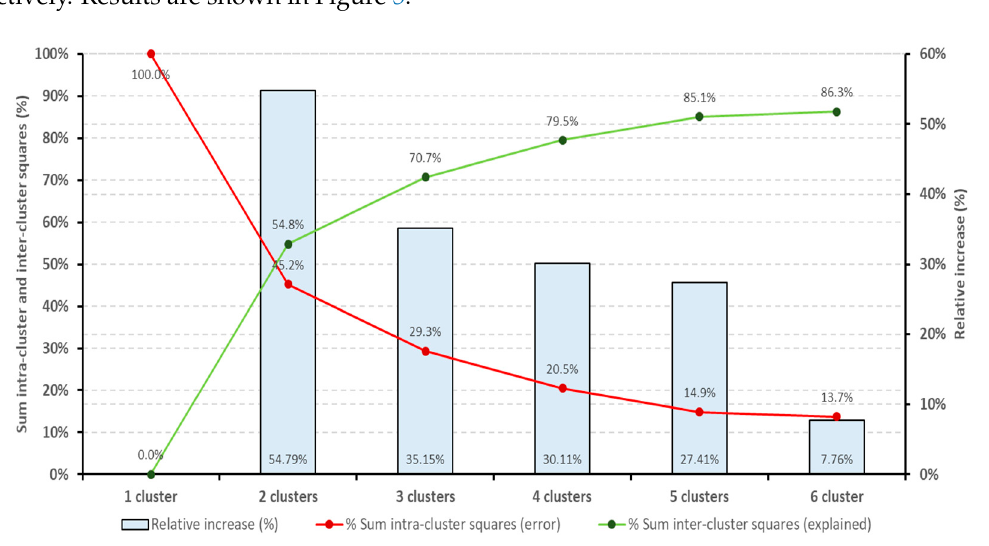
Figure 5. Results for the k -means clusterization method according to the number of clusters.